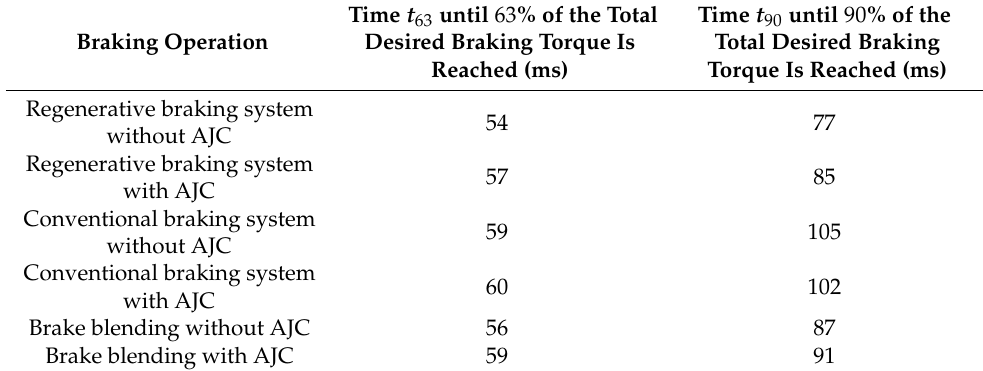
Table 1. Overview of the rise times for the different braking